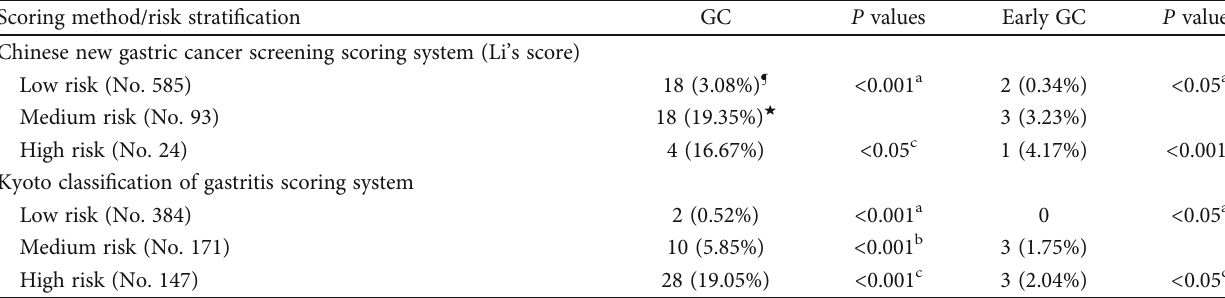
Table 5: Comparison of gastric cancer results between the two scoring methods.